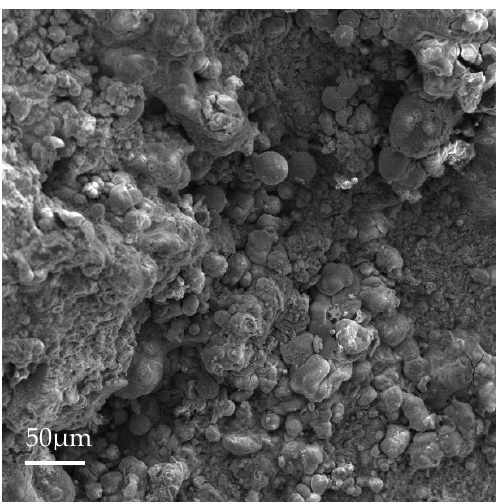
Figure 14. Mesoscopic morphology of Region C—instantaneous fracture region.